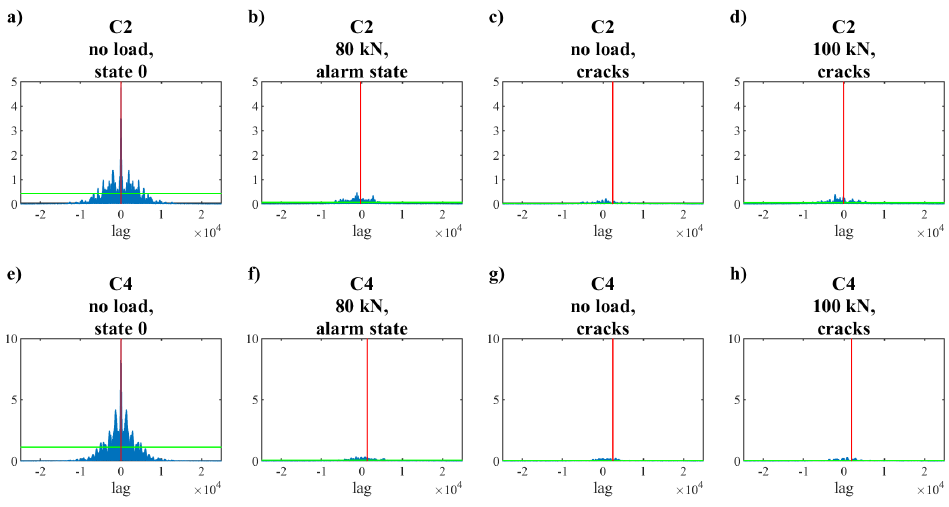
Figure 8. Examples of absolute values from correlation of the signals. The base signal for each selected sensor was its normalized signal from State 0. The centers of gravity of the presented functions were calculated and are shown on the crossing of red and green